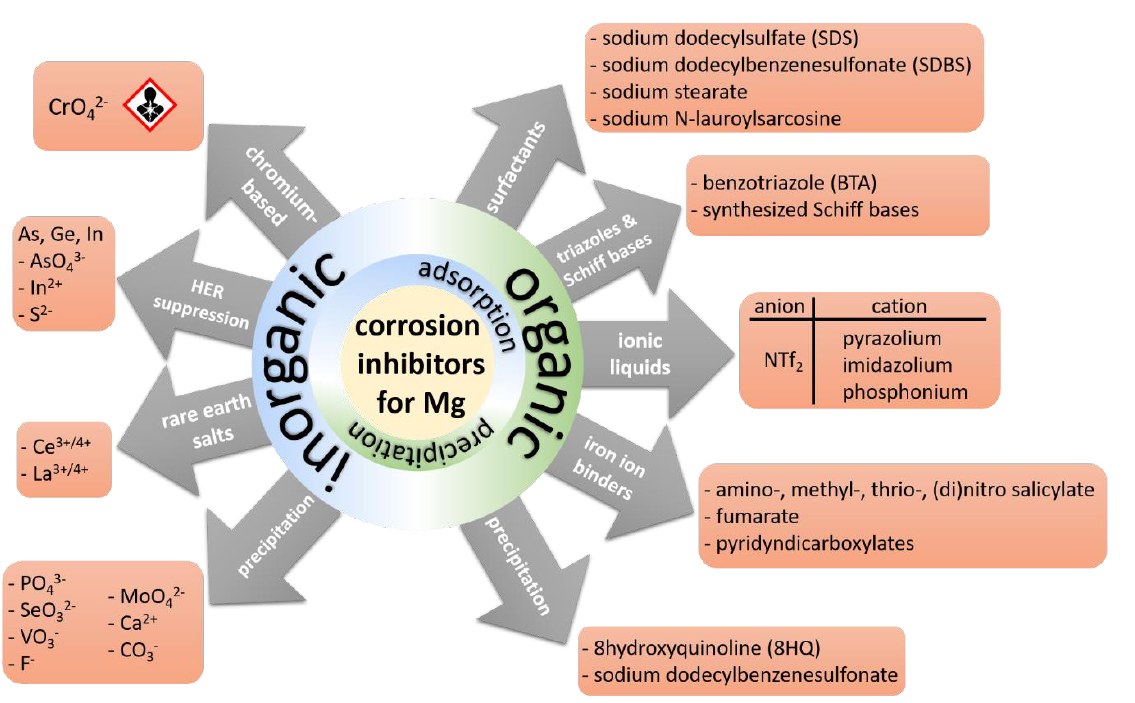
Figure 14. General overview of different categories of corrosion inhibitors for Mg and its alloys with their most effective examples.